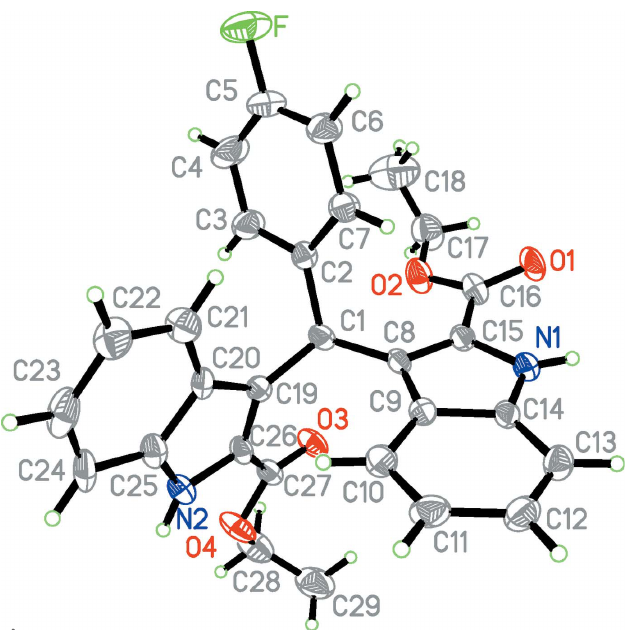
Table 1 for details), forming layers parallel to the ab plane (Fig. 2). There are C—H (cid:3) (cid:3) (cid:3) (cid:2) interactions present linking the layers to form a supramolecular three-dimensional network (Table 2 and Fig. 2).